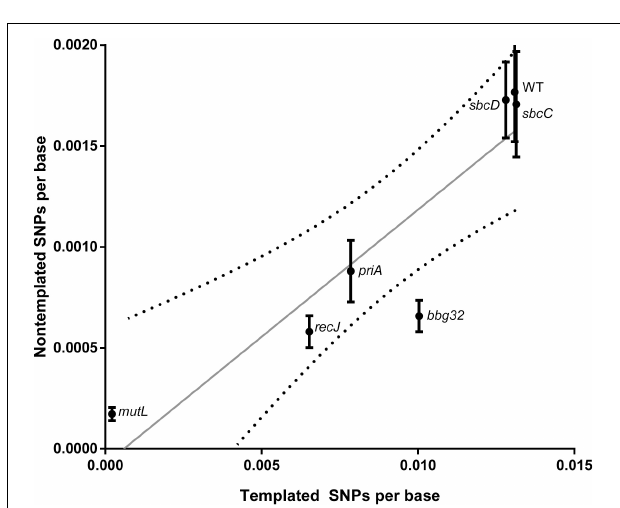
FIGURE 5 | Frequency of non-templated SNPs versus templated SNPs at 5 weeks for WT and each gene disruption mutant. The unit of observation is each base sequenced, and the mean ± SEM is shown. A least-squares regression line and associated 95% confidence bands (dotted lines) are